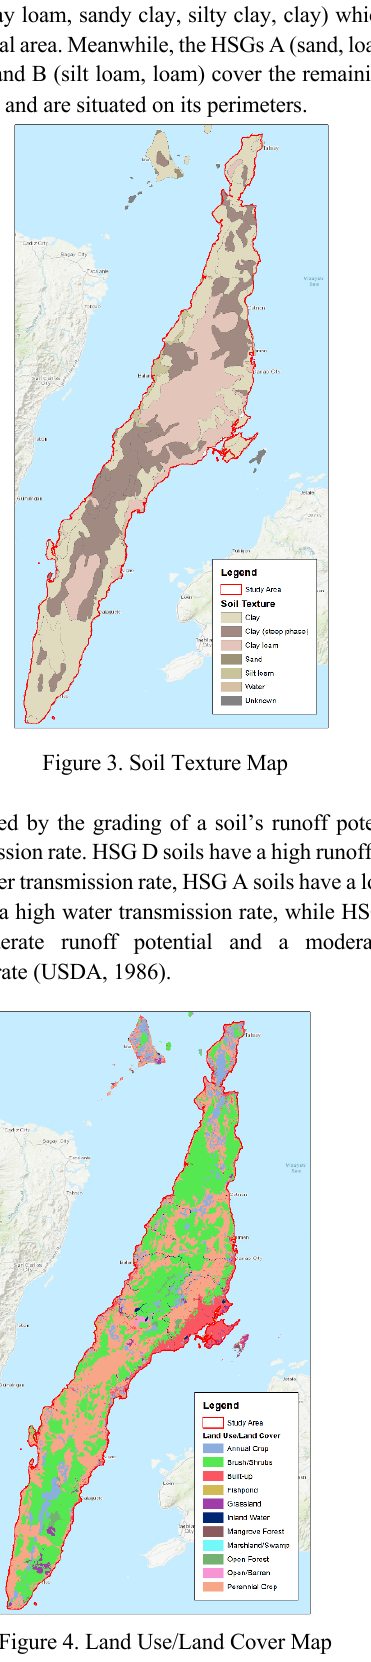
Figure 4. Land Use/Land Cover Map